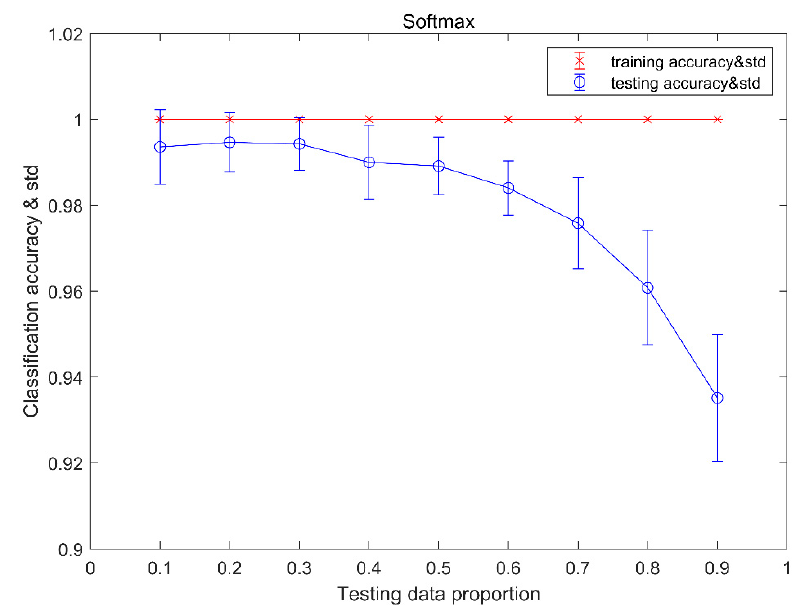
Figure 9. The classification accuracy and the standard deviation of the stand-alone SoftMax classifier.